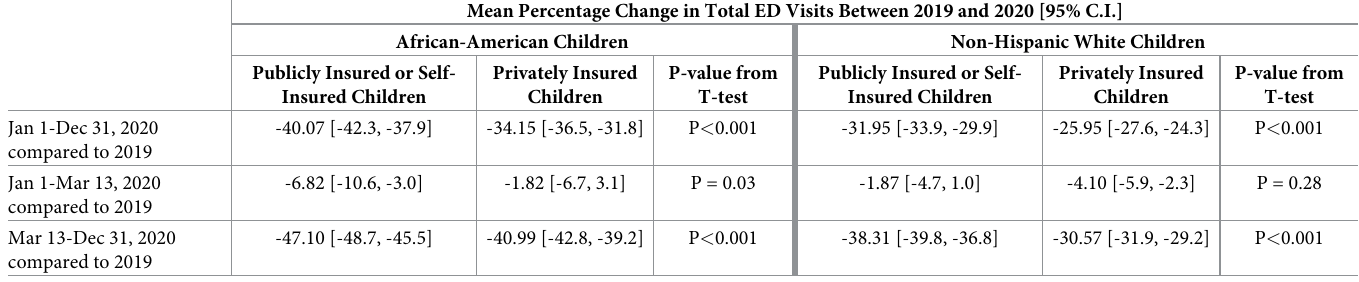
Table 3. Differences in the mean date-specific percentage changes in 2020 compared to 2019 for total ED visit counts between privately insured & publicly/self- insured children, by race. Mean Percentage Change in Total ED Visits Between 2019 and 2020 [95%